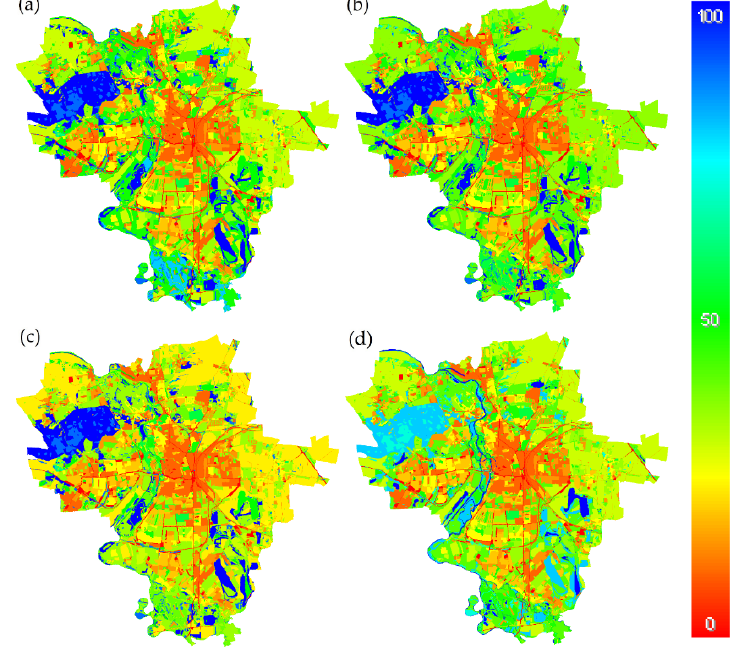
Figure 5. Capacity maps for the regulatory ecosystem services: ( a ) global climate regulation, ( b ) local climate regulation, ( c ) air pollution control, and ( d ) water cycle regulation. Value 100 (blue) = highest ecosystem service capacity; 0 (red) = lowest/no ecosystem service